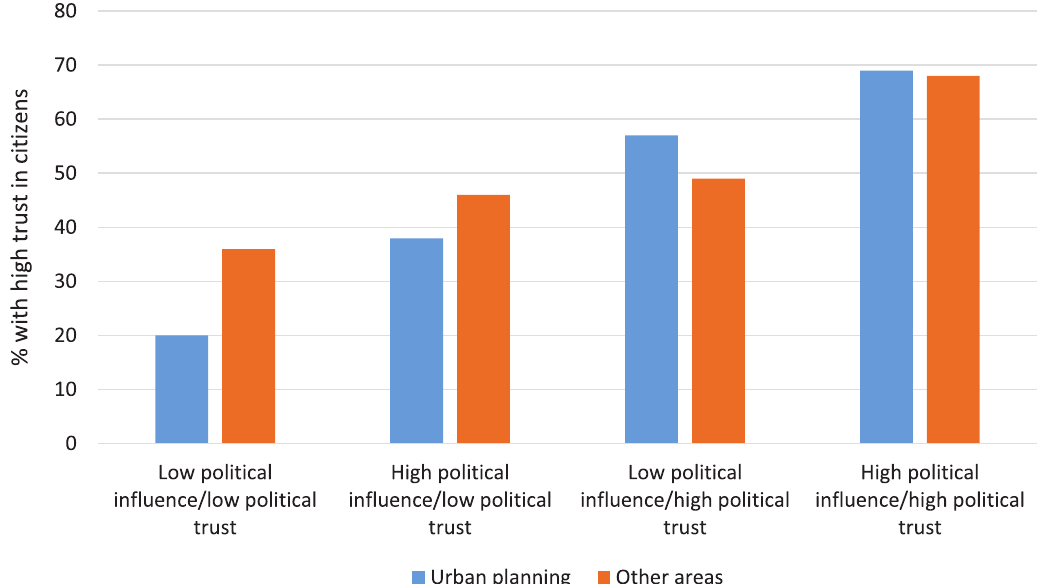
Figure 1. Politico-administrative relations and trust in citizens (percentage high trust in citizens). Source: Own survey